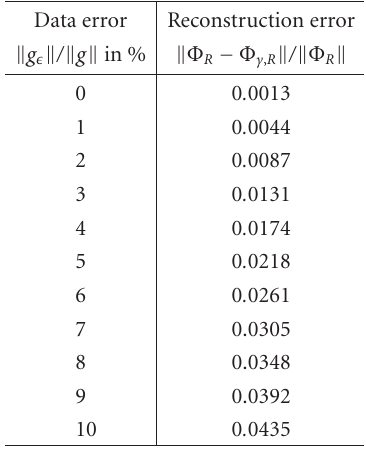
Table 1: Reconstruction error of the radiating source. Data